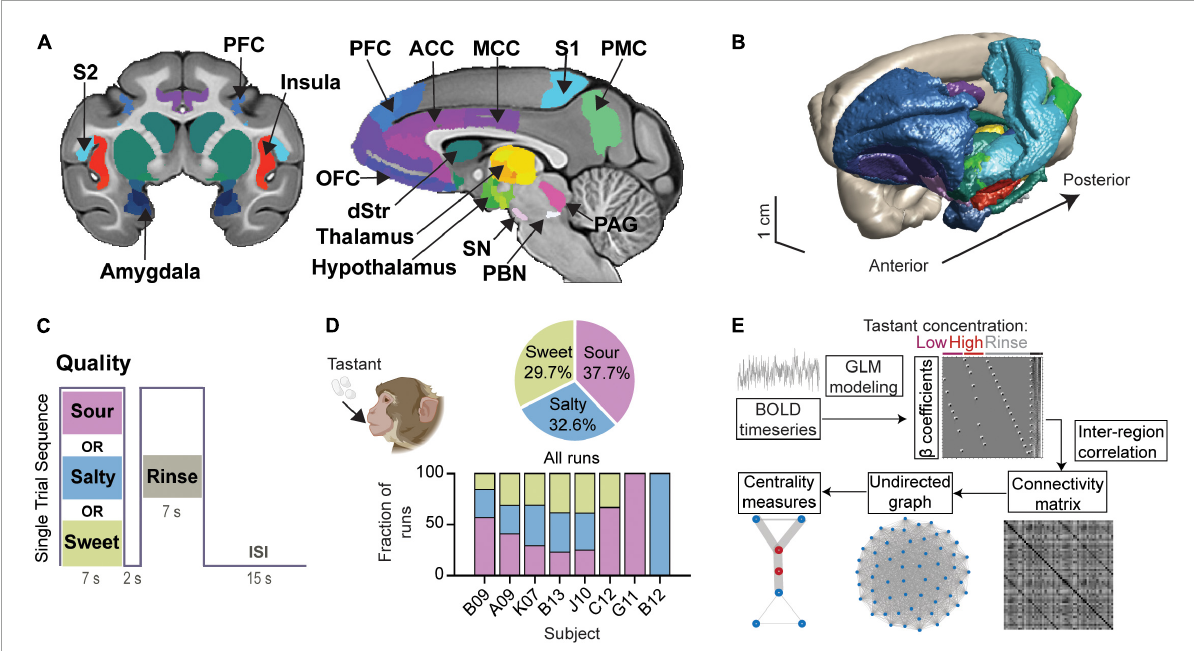
FIGURE1 Modeling the gustatory connectome in the adult macaque monkey. (A) Coronal and mid-sagittal sections from the base template image of the CHARM and SARM macaque monkey brain atlases indicating the regions included in the gustatory connectome. ACC, anterior cingulate cortex; dStr, dorsal striatum (caudate and putamen); MCC, mid-cingulate cortex; OFC, orbitofrontal cortex; PAG, periaqueductal gray; PBC, parabrachial complex; PFC, prefrontal cortex; PMC, posterior medial cortex (area 7m, precuneus); S1, primary somatosensory cortex; S2, secondary somatosensory cortex; SN, substantia nigra. (B) A 3D surface view of the macaque monkey taste connectome, with regions colored as shown in panel (A) . (C) Stimulus block design for a single trial sequence. Each run consisted of 15 tastant (pseudorandomized low and high concentration presentation) and 15 rinse solution delivery blocks. An inter-stimulus interval (ISI) of 15 sec separates each trial of taste-rinse presentation. (D) Pie chart of the percentage of runs per taste quality (upper panel, n = 104, 90, 82 for sour, salty, and sweet, respectively). The number of runs for each subject were: B09, n = 51; A09, n = 54; K07, n = 51; B13, n = 52; J10, n = 44; C12, n = 12; G11, n = 7; B12, n = 5. The fraction of runs for each taste quality across animals is illustrated by the bar plot (lower panel). Animal cartoon (upper left) adapted from BioRender.com. (E) Schematic demonstrating the steps involved in deriving the β coefficients, connectivity matrix and graph centrality measures for the gustatory connectome. Representative design matrix used for estimating β coefficients (upper). The undirected connectivity matrix (lower middle) was generated from the BOLD signal through general linear modeling and β -series correlation. Runs were modeled analogously for three event types (low-, high-concentration tastant, and rinse solution) across taste qualities (sour, salty, and